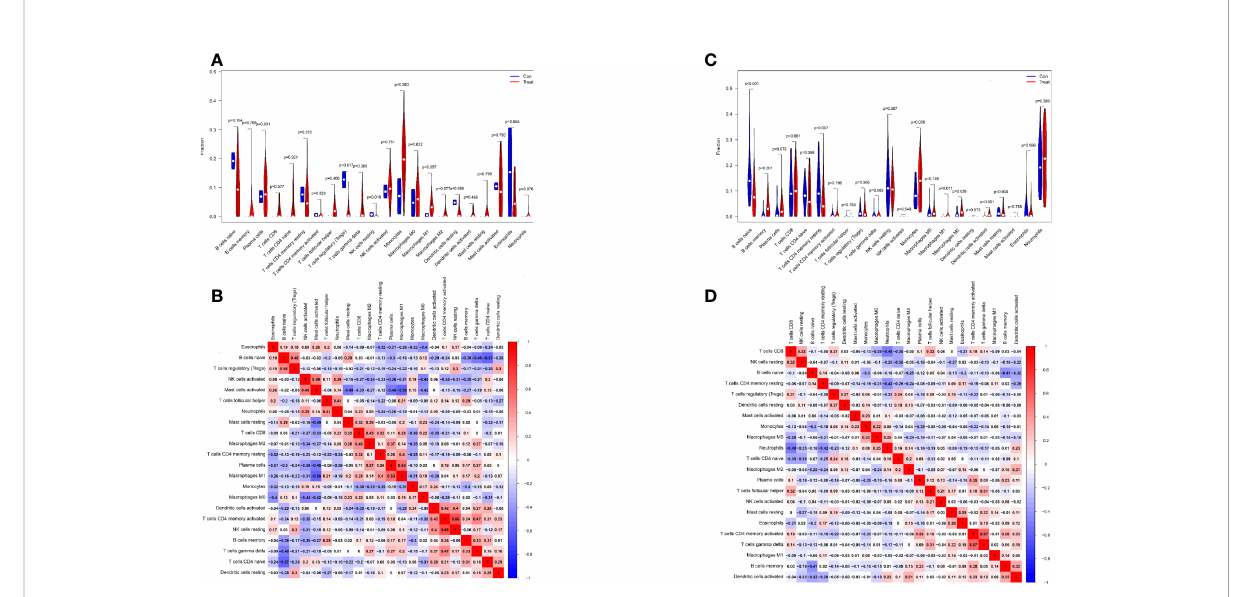
FIGURE 7 Distribution and visualization of immune cell in fi ltration. (A, C) Comparison of 22 immune cell subtypes in LN and normal tissues. (A, C) LN compared with 22 immune cell subtypes in normal tissue. Blue represents control group, red represents LN kidney group ( (A) LN, (C) peripheral blood group). (B, D) Heatmap of correlations between 22 immune cell subtypes. Both horizontal and vertical axes show immune cell subtypes, and the values inside represent the correlation coef fi cients of immune cells. Red represents positive correlation and blue represents negative correlation. The darkest red lattice represents the highest positive correlation between the two genes, and the darkest blue lattice represents the most signi fi cant negative correlation between the two